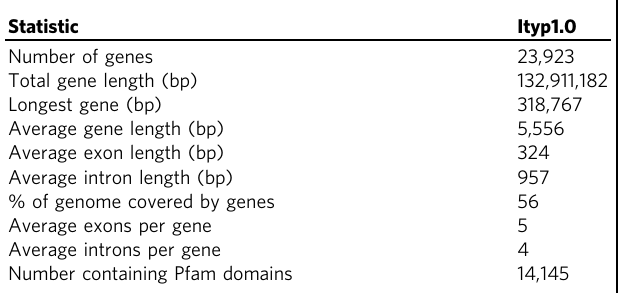
Table 2 Statistics of the predicted gene models from the Ips typographus draft assembly